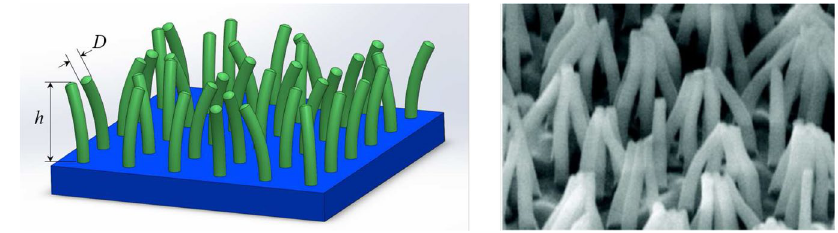
Figure 1. Left side: an example of micro-structured surface with bristle-like micropillars. Right side: a SEM image of ordered low-density polyethylene (LDPE) nanofiber arrays adapted with permission from Ref. 12 . Copyright 2011 American Chemical